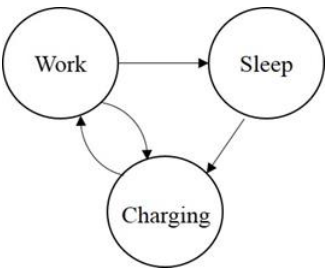
Figure 3. Typical robot operation–charge cycle.